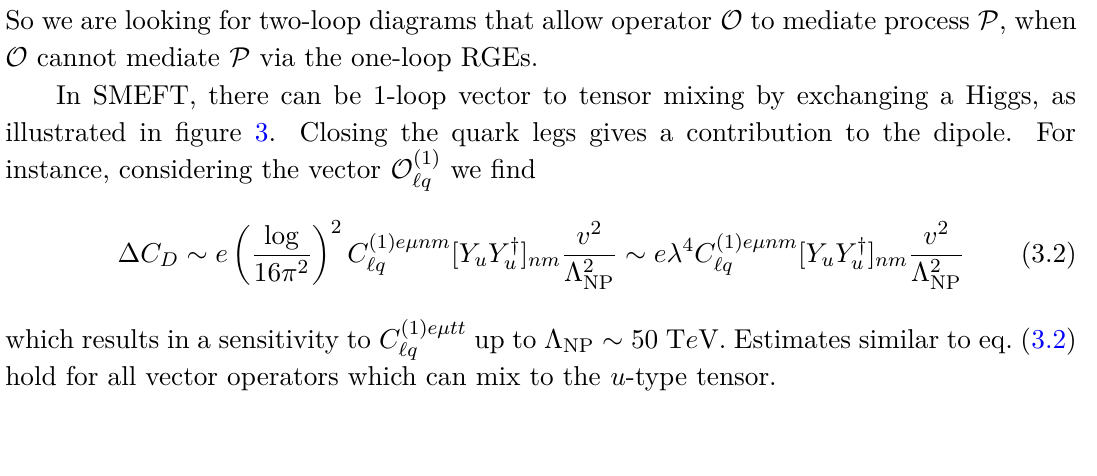
Figure 3 . Vector mixing to the tensor via Higgs